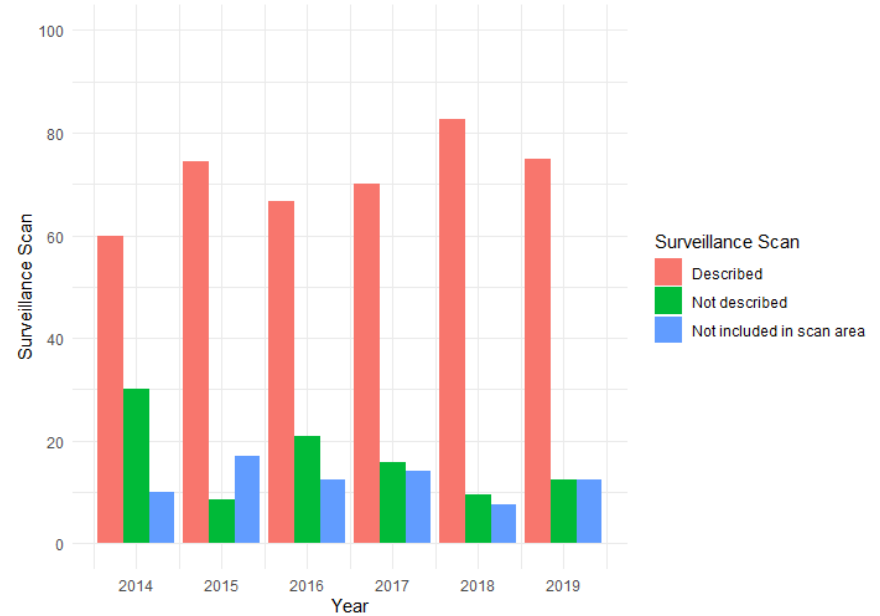
Figure 3. Figure illustrating the distribution of surveillance scans in the entire cohort not representing debut of cancer ( n = 394). No linear decrease or increase were seen in the distribution of surveillance scans in the study period.